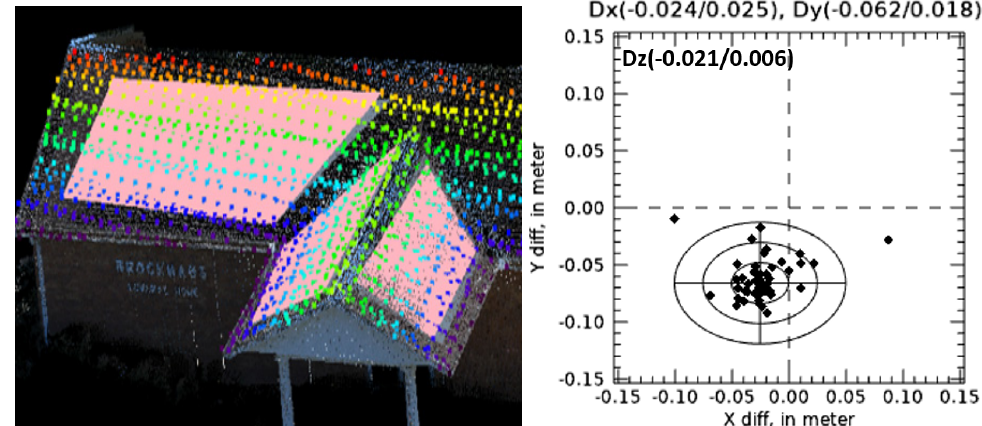
Figure 4. Reference TLS and airborne point cloud from a multi-plane building ( left ) and the distribu- tion of repeated amorphous object-based solutions from a multi-plane building ( right ).